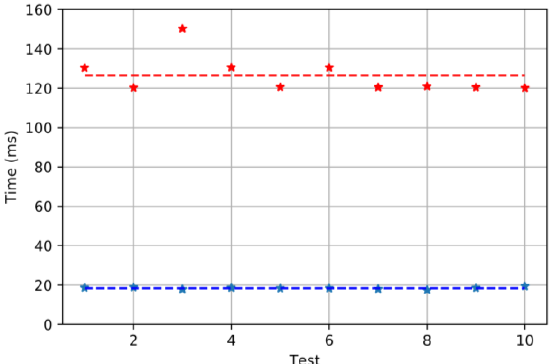
Figure 14. Ten tests run with both PFM and PWM controllers. The blue dots represent the angle reached during each test with PFM and the red dots when PWM is used. The average angle is also shown: 18.38 ms for the PFM and 126.44 for the PWM.